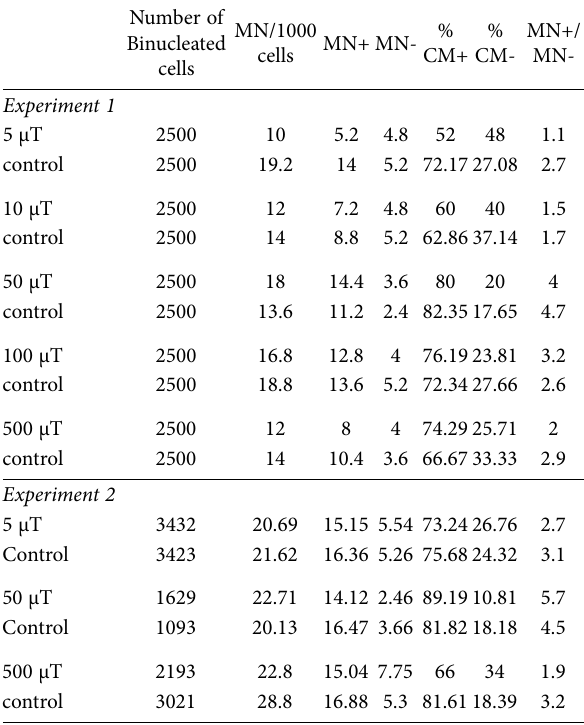
Table 1. Summary of two independent experiments on ELF-MF’s exposed C3A cells following FISH-staining of